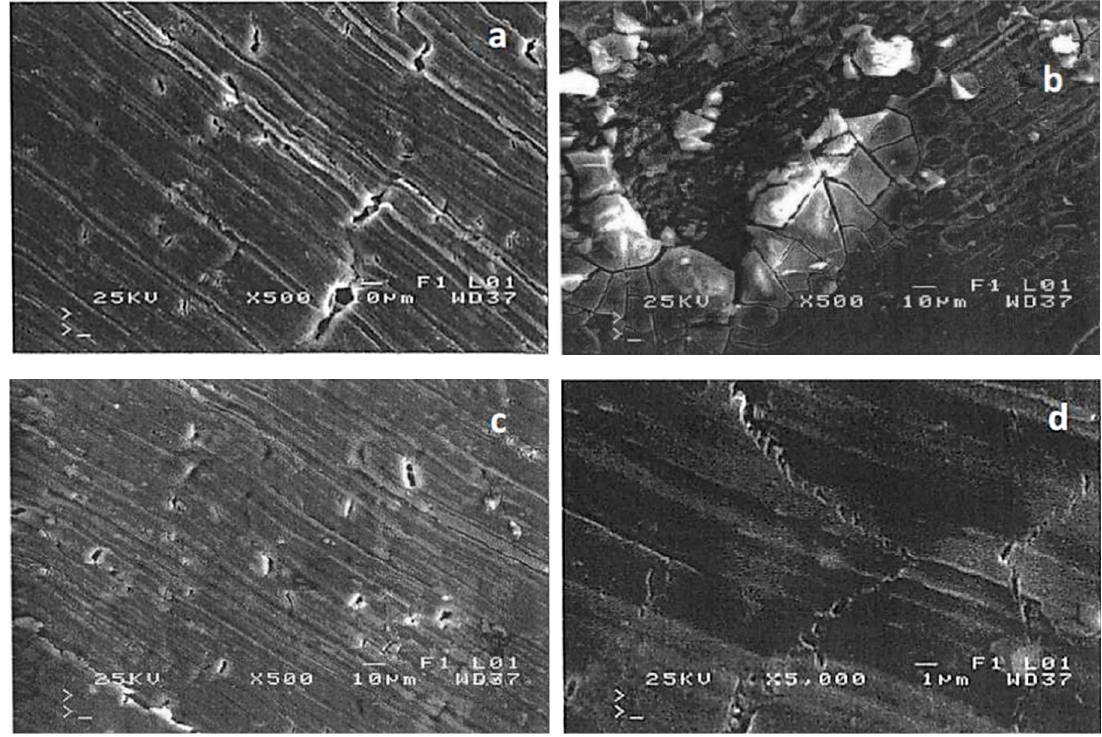
Figure 6. SEM analysis of the surface near the fractured area of T6 treated 6082 aluminum alloy, after SSRT testing in ( a ) air, ( b ) pH = 3, ( c ) pH = 7 and ( d ) pH =